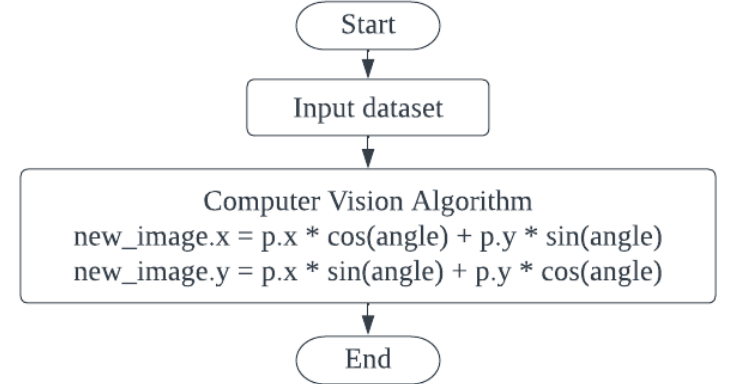
Scheme 1. Image processing (rotation).